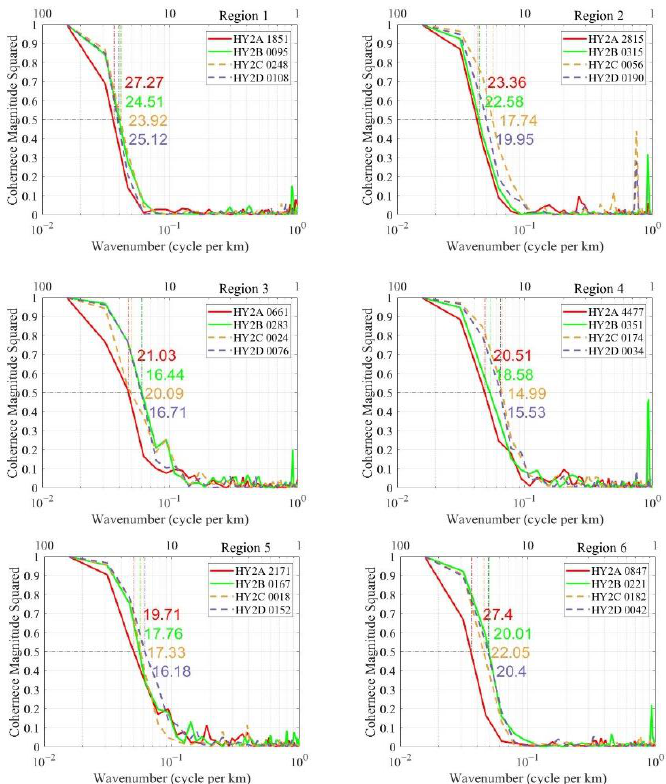
11 of 26 Figure 5. Variation trend of geoid heights along sample data sequences for HY-2A, HY-2B, HY-2C and HY-2D: Region 1, North Pacific; Region 2, South Pacific; Region 3, Mid-Pacific; Region 4, Indian Ocean; Region 5, North Atlantic; Region 6, South Atlantic. We applied a Hanning window to constrain the effect of spectrum leakage caused by the limited length of the data sequence. Through the averaging effect of the Hanning win- dow, the main lobe reduced the fluctuation in the power spectrum and then achieved a smaller estimated variance. A wider main lobe is advantageous for a more effective aver- aging effect and smaller variance but has decreased resolution. A stronger side-lobe effect caused more errors in signal recognition and weak signals were indistinguishable. Hence, the size of the Hanning window had to be optimally determined by considering both the main- and side-lobe effects. A 64 km Hanning window was used in this study and the power spectrum was estimated by the Welch method. The resolution capabilities were uniformly determined while the coherence dropped to 0.5, indicating a signal-to-noise ratio of 1 [31]. As shown in Figure 6, all the HY-2 missions had stable resolution capabili- ties in the 50+ km wavelength range. The coherence was close to 1, indicating that the signal occupied this band. While the coherence was around 0.5, different variations oc- curred for different missions and regions. The specific results are listed in Table 4. Gener-